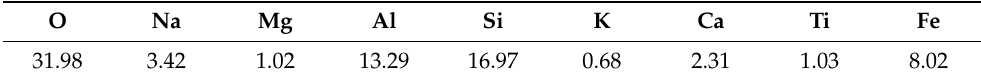
Table 2. EDX analysis, % atomic.